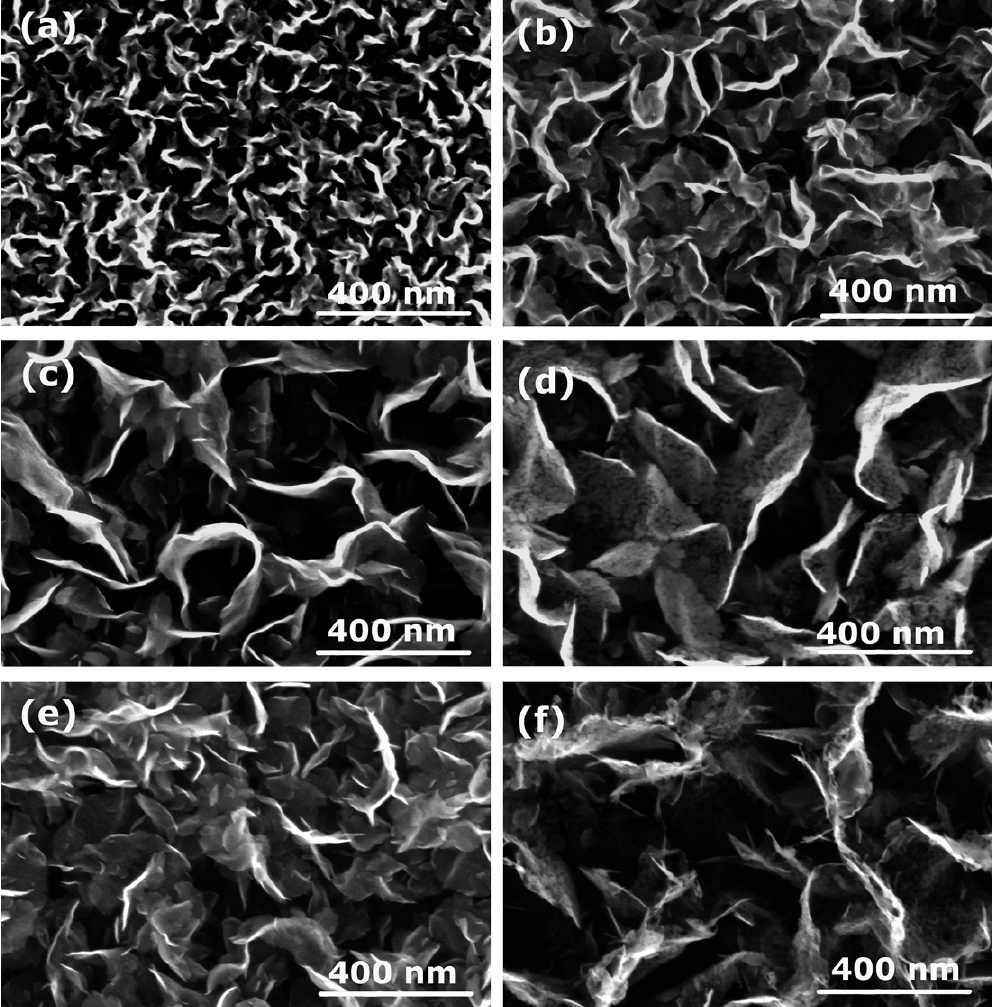
Figure 2. SEM images of CNWs for various deposition times in N 2 plasma when using PP